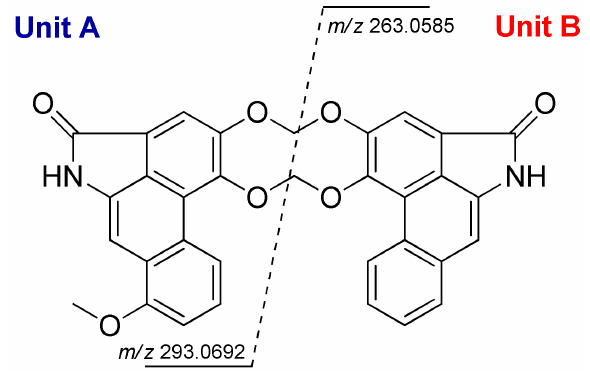
Figure 3. Mass spectral fragmentation of 1 .